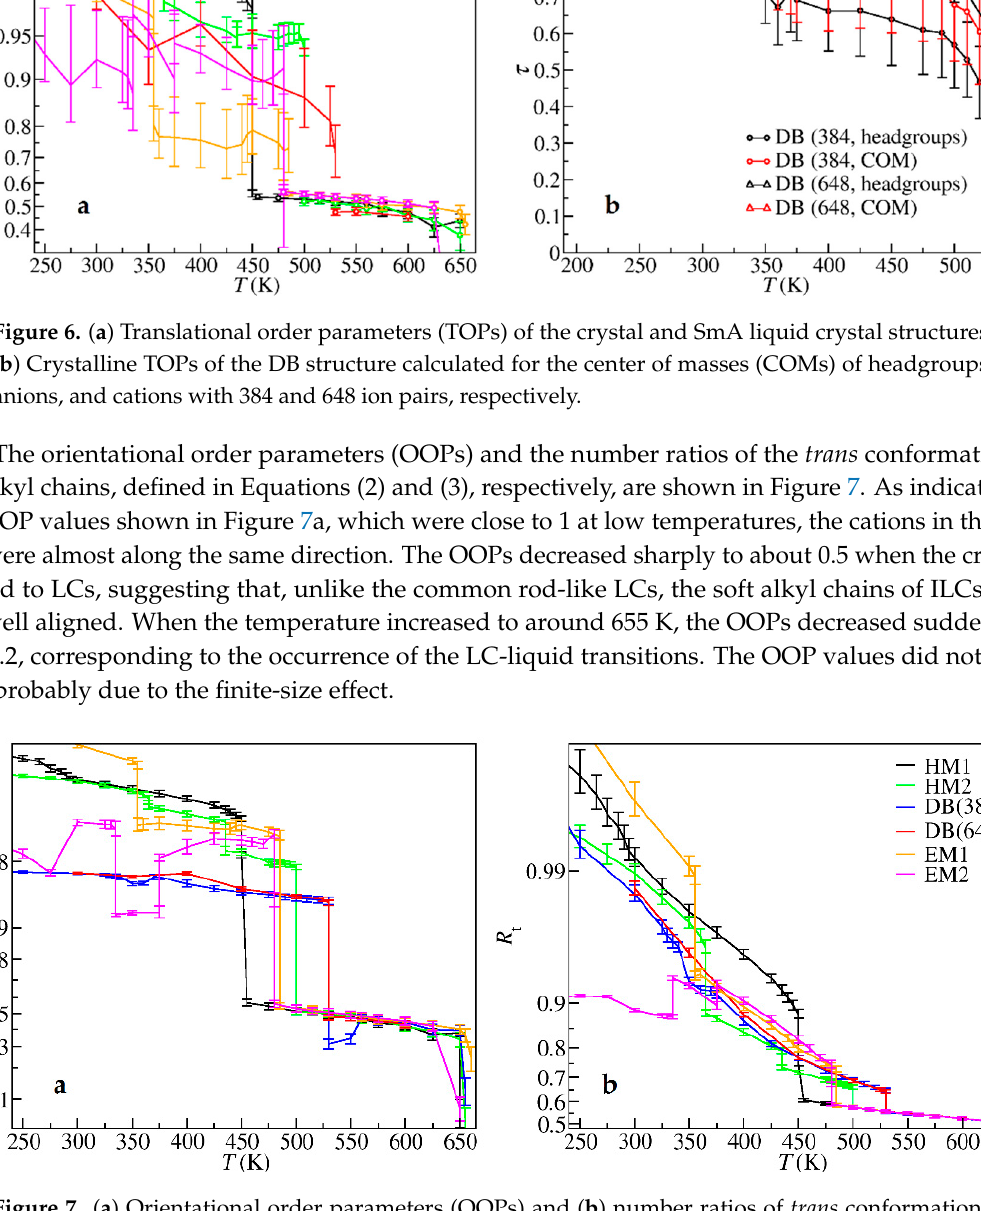
Figure 7. ( a ) Orientational order parameters (OOPs) and ( b ) number ratios of trans conformations versus temperature during